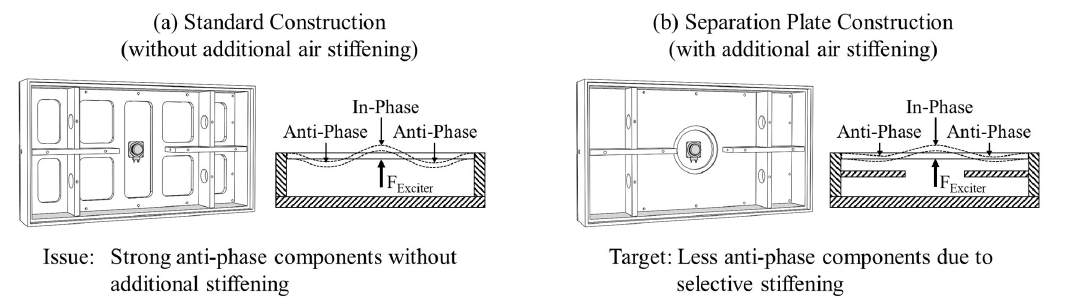
Figure 8. Visualization of the selective air stiffening caused by an additional separation plate exemplary for the third structural mode.